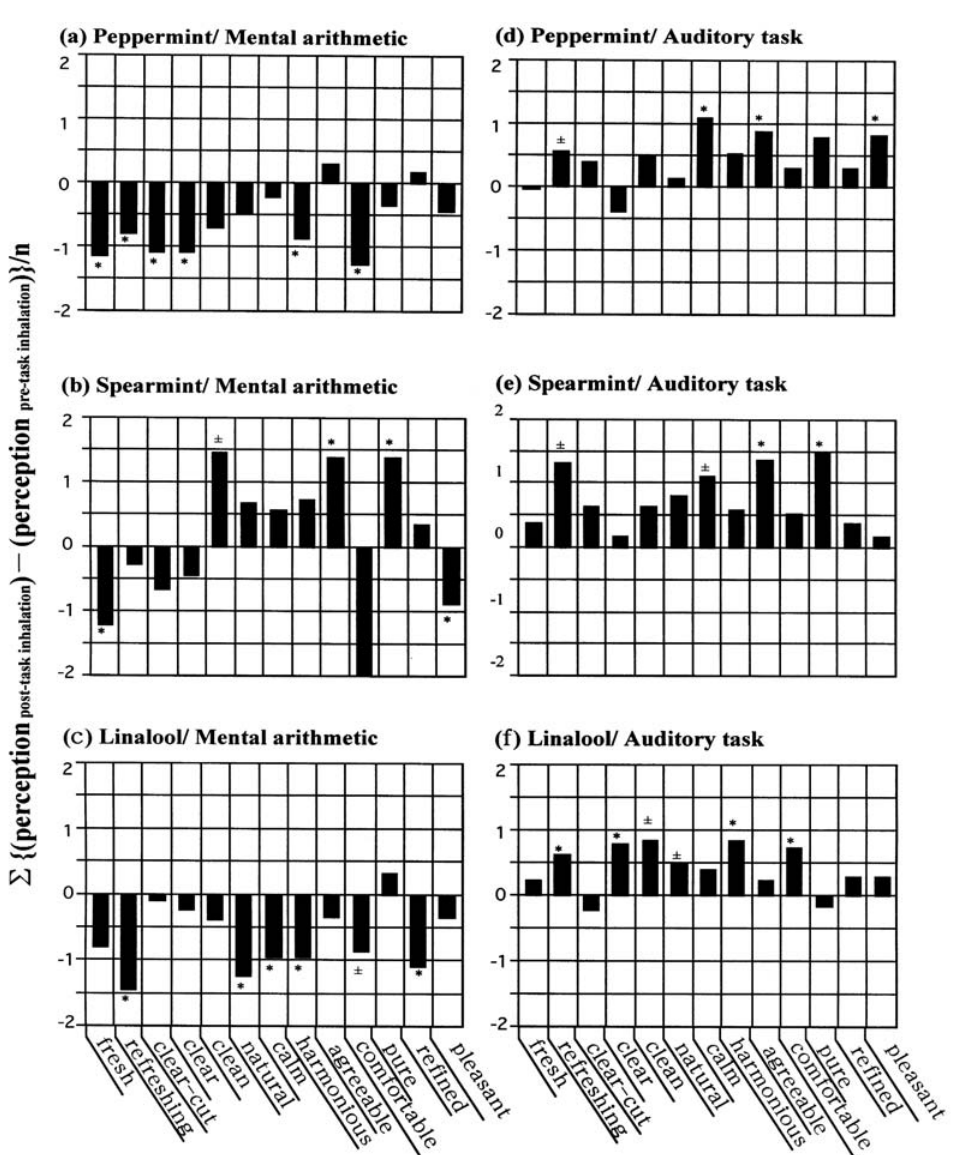
Figure 1. Sensory spectra of peppermint and spearmint essential oils and linalool as a function of behavioural task. Redrawn from Sugawara et al. [15]. A sensory test was conducted twice before and after the task assigned to the subjects, in which aroma perception was evaluated by 13 impression descriptors consisting of contrasting pairs of